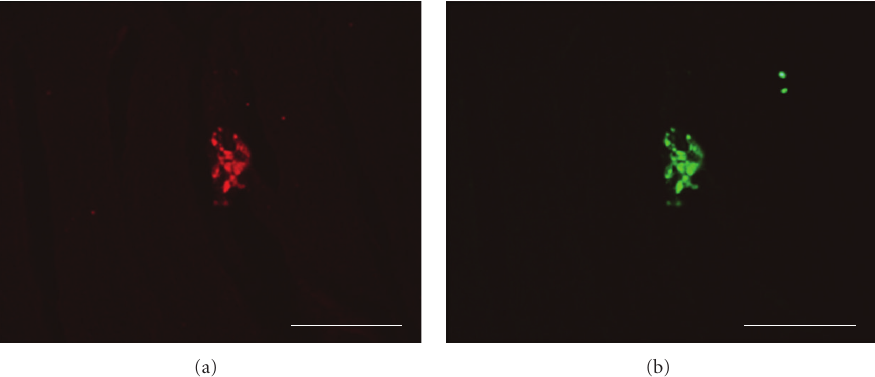
Figure 5: Double BrdU-NeuN immunohistochemistry on a sagittal section from a neurosphere-grafted bridged nerve at 90 days after lesion. One given field was sequentially photographed with fluorescent wavelengths revealing, respectively, Alexa-594-labeled BrdU immunoreactivity (a) and Alexa-488-NeuN one (b). Note the extensive nuclear colocalization of the mature neuron marker NeuN with BrdU (b). Scale bars 100mm.